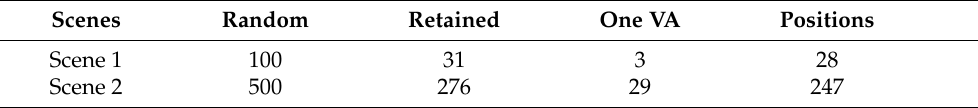
Table 2. Random positions for the robot in both the scenes. Scenes Random Retained One VA